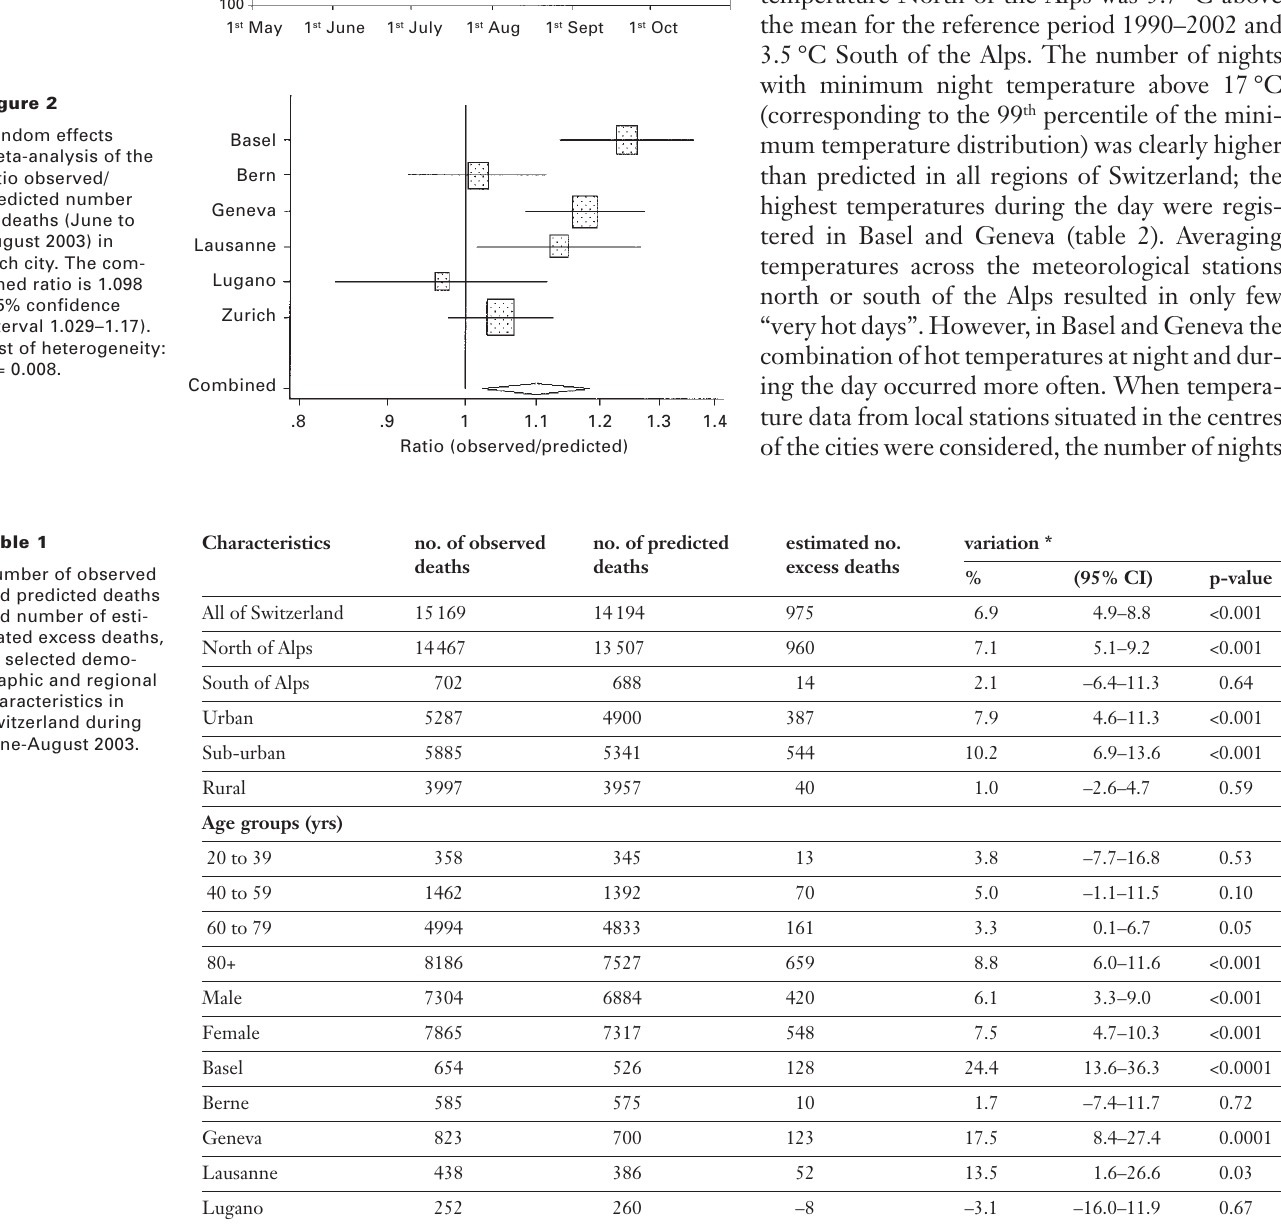
Figure 2 Random effects meta-analysis of the ratio observed/ predicted number of deaths (June to August 2003) in each city. The com- bined ratio is 1.098 (95% confidence interval 1.029–1.17). Test of heterogeneity: p =